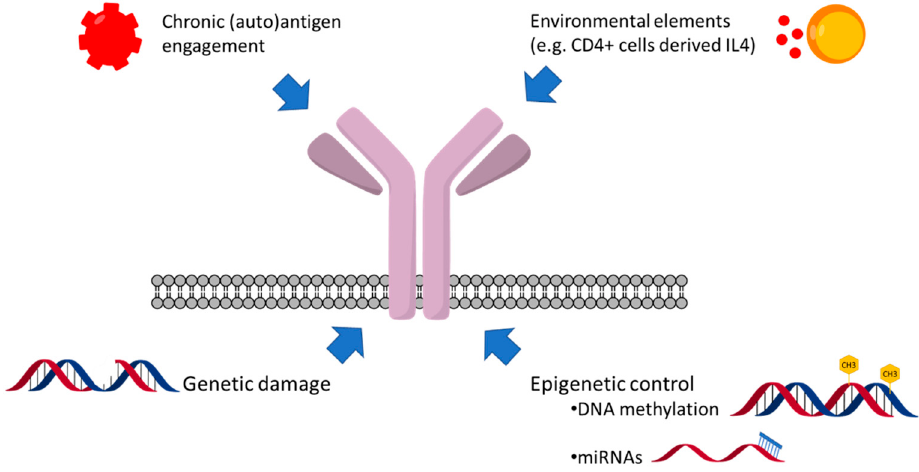
Figure 1. Microenvironmental and (epi)genetic factors influencing surface IgM levels and signaling capacity in CLL.